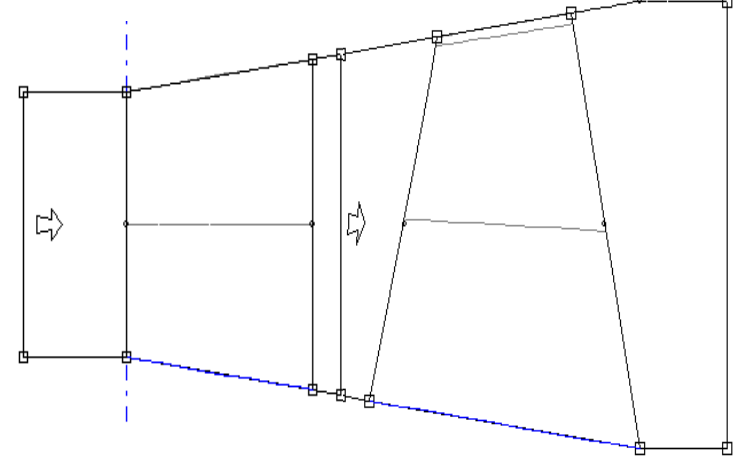
Figure 11. Meridional side view of preliminary blades.